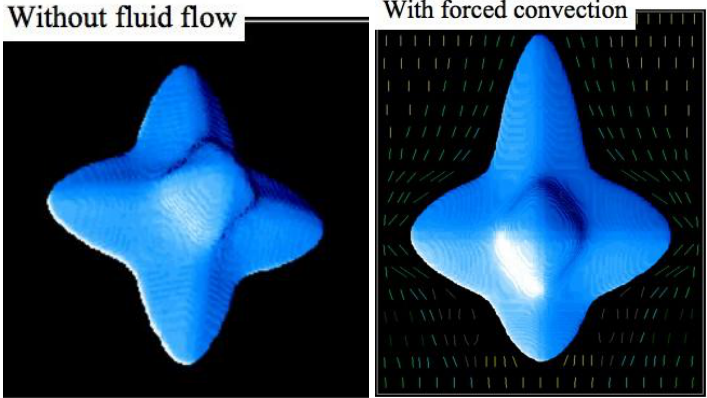
Figure 5. Equiaxed dendrite within an undercooled liquid, without ( left ) and with ( right ) convection; fluid flow streams from top to bottom on the right picture; results from phase field modelling